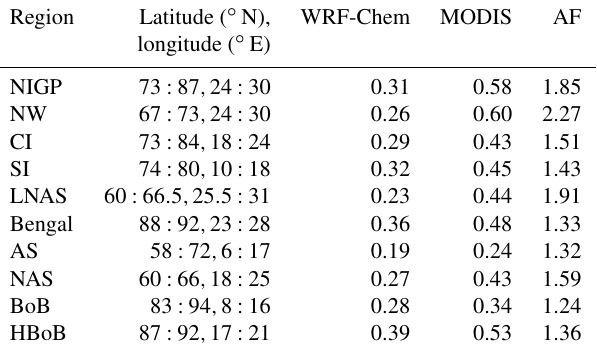
Table 3. Comparison of WRF-Chem-simulated AOD with MODIS. AF: adjustment factor (MODIS AOD/model AOD). The meanings of the abbreviations are as follows. NIGP: North India and Gangetic plains; NW: northwestern part of the Indian sub-continent; CI: cen- tral India; SI: southern India; LNAS: land mass north of the